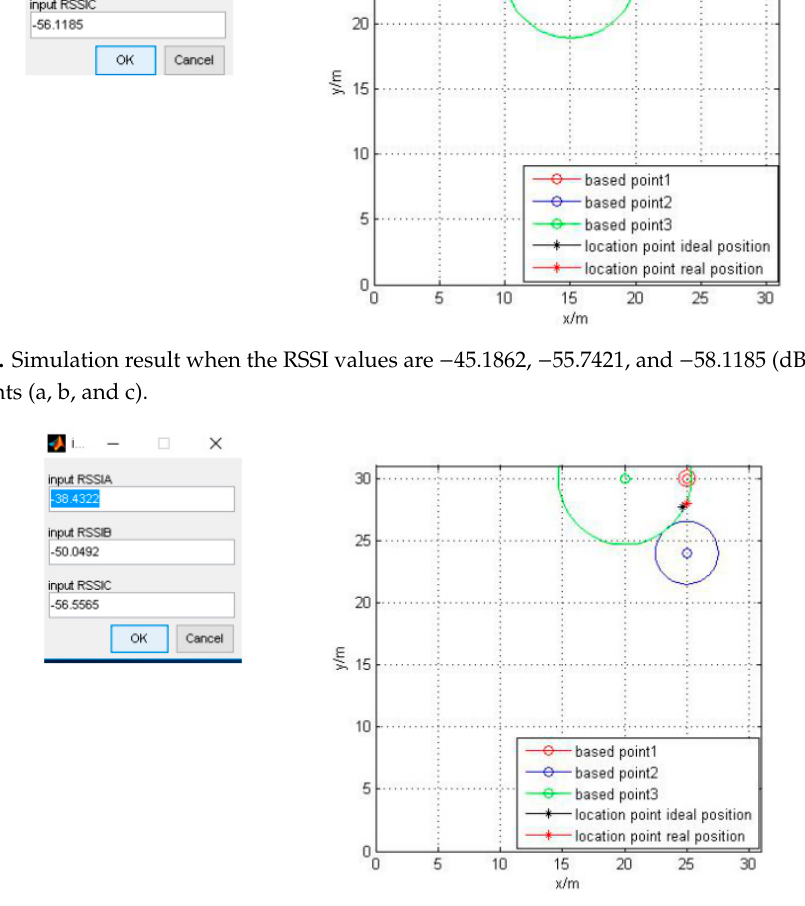
Figure 11. Simulation result when the RSSI values are − 38.4322, − 50.0492, and − 58.5565 (dBm) for the three points (a, b, and c).